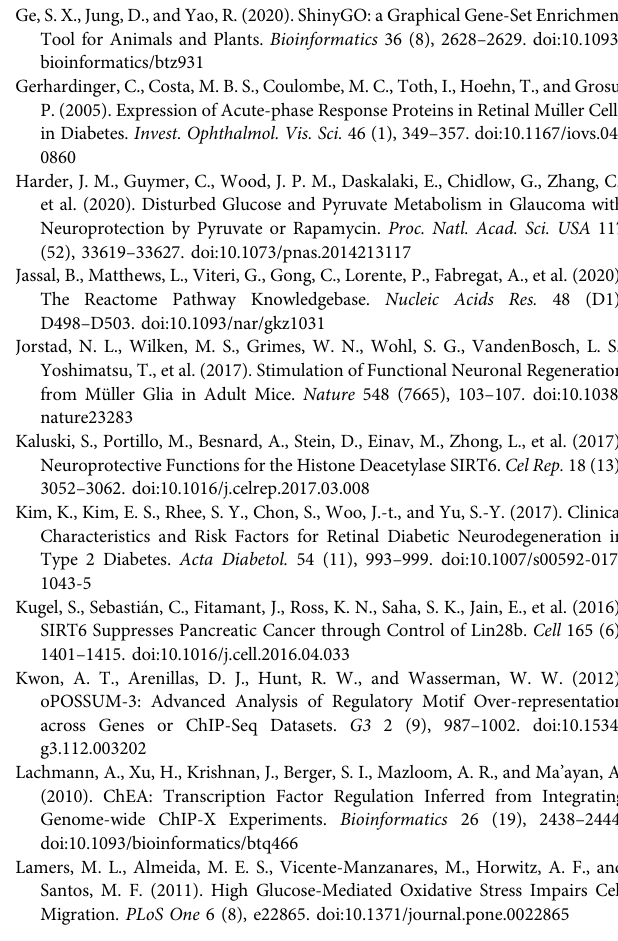
Supplementary Table 1 | Differential expression analysis. Supplementary Table 2 | GO Enrichment analysis. Supplementary Table 3 | Reactome. Supplementary Table 4 | KEGG pathways. Supplementary Table 5 | Chromatin Enrichment analysis (ChEA). Supplementary Table 6 | Opposum analysis. Supplementary Table 7 | GO Enrichment analysis of putative